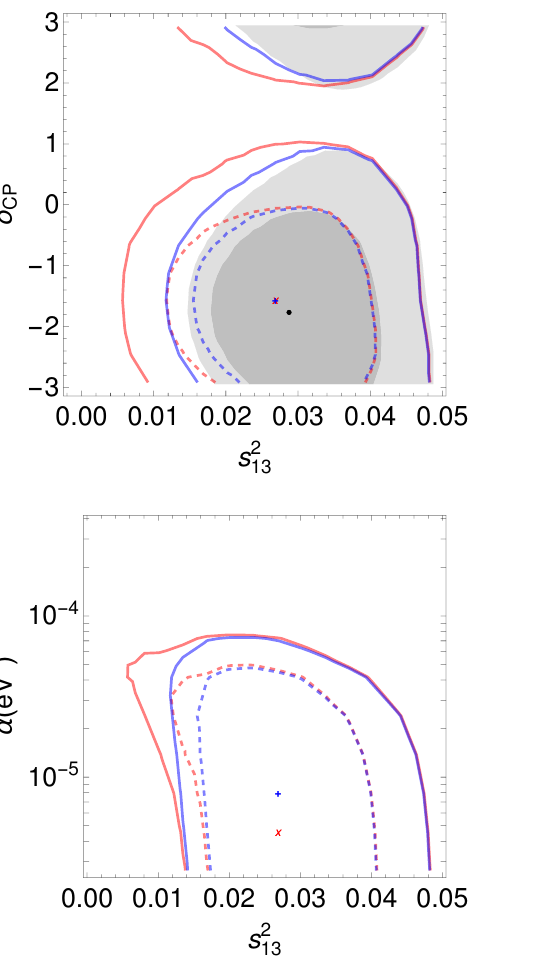
Figure 4 . Correlations in neutrino parameters, for scalar (red) and pseudoscalar (blue) couplings, using data from the T2K neutrino and antineutrino runs. The dashed lines show 1 (cid:27) contours, while the solid line indicates the 90% C.L., as is done in the original T2K analysis. Shaded regions show corresponding contours in the SO scenario. The black dot, red (cid:2) and blue + indicate the best-(cid:12)t